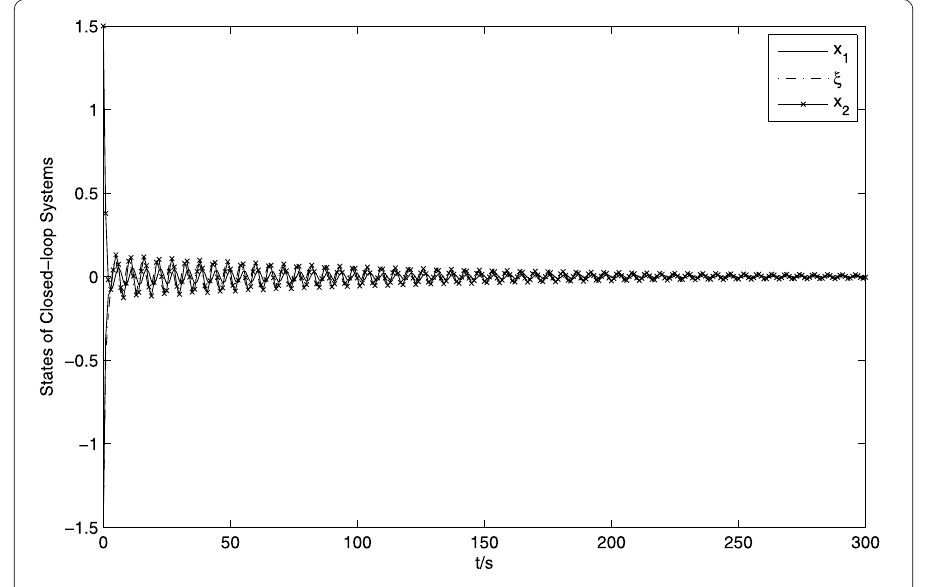
Figure 2 The state response of closed-loop system (5) with ε =